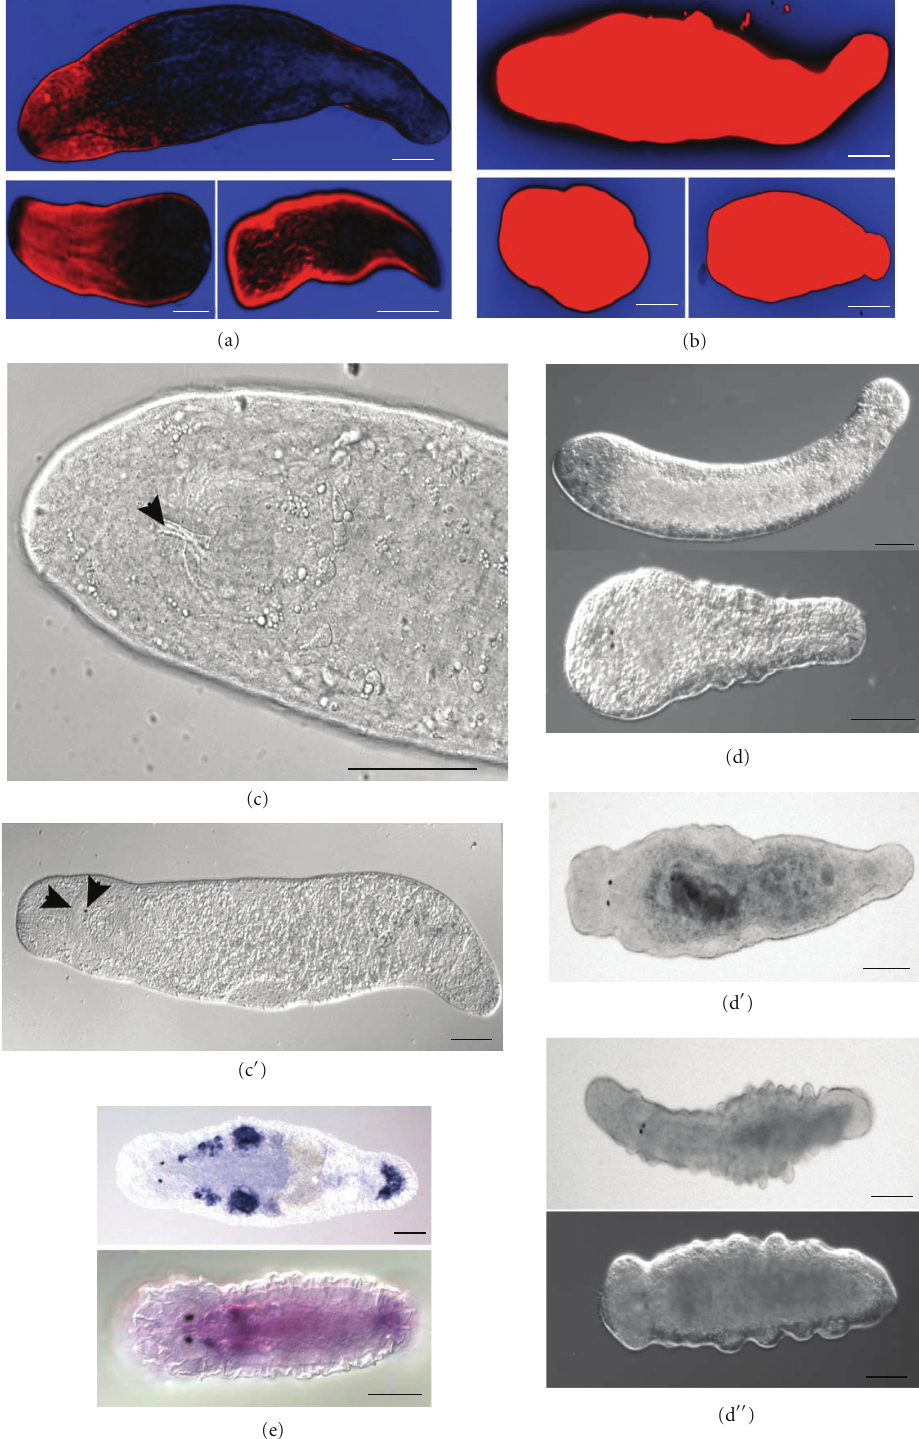
Figure 3: Bioelectric signaling and stem cells in M. lignano . (a-b) DiBAC 4 (3) staining of intact worm (top), anterior (left bottom) and posterior (right bottom) fragments. (a) control worm, (b) worm treated with 1 μ M IVM. Blue is more polarized than black, black is more polarized than red. (c-c (cid:2) ) Regeneration of head-specific structures after 1 μ M IVM treatment. Arrowheads in (c) indicate regenerated pharynx, in (c (cid:2) ) regenerated eye and half of the brain. (d-d (cid:2)(cid:2) ) intact worms exposed to high doses of IVM (2 μ M in d and 4 μ M in d (cid:2) ) and PZQ (150 μ M in d (cid:2)(cid:2) ). (d) head regression; (d (cid:2) ) square head; (d (cid:2)(cid:2) ) bulges and outgrowth. (e) In situ hybridization results in adult (top) and juvenile (bottom) animals with the probe against RNA815 5834 transcript from ML110815 transcriptome assembly (voltage-gated sodium channel). In juvenile worm this gene is expressed almost ubiquitously, and in adults expression is only detected in gonads and (likely) in somatic stem cells. Strong signal in the adhesive glands in the tail is likely a common